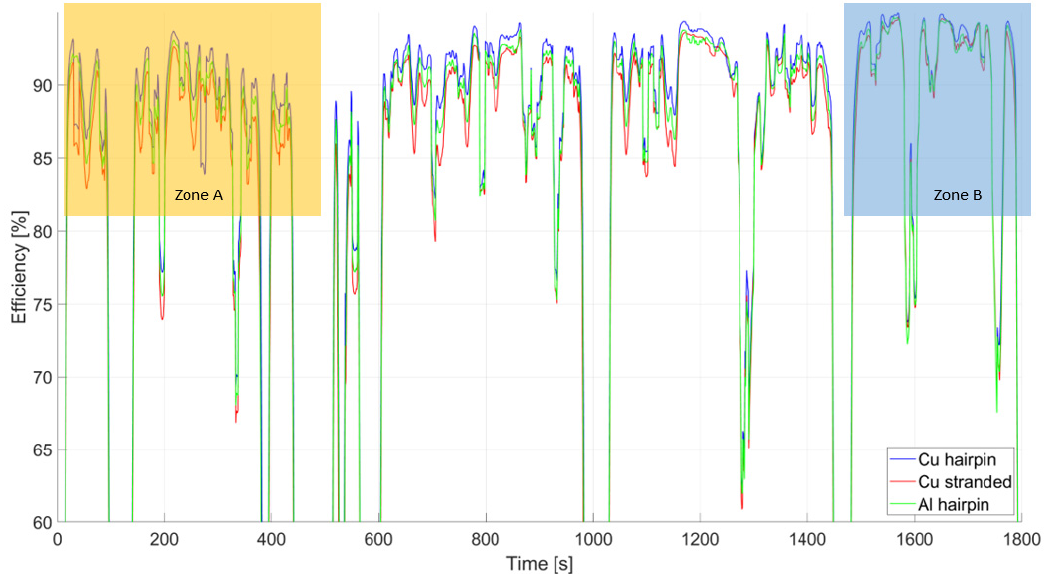
Figure 10. Efficiency in WLTP class 3 drive cycle.